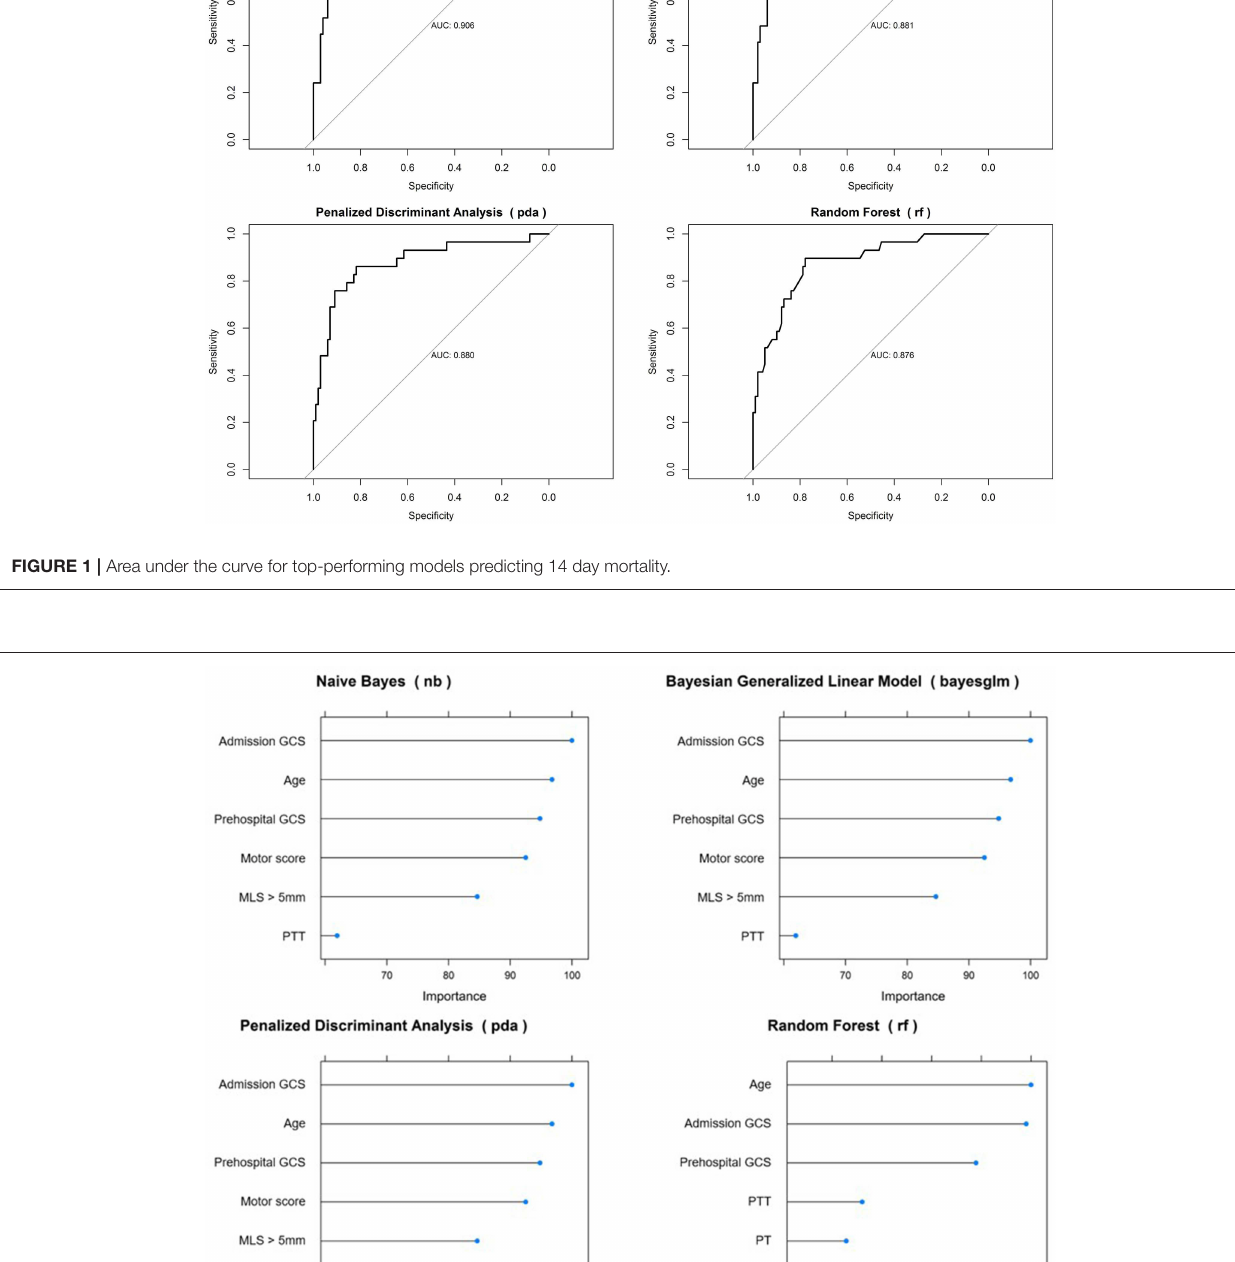
Frontiers in Neurology | www.frontiersin.org